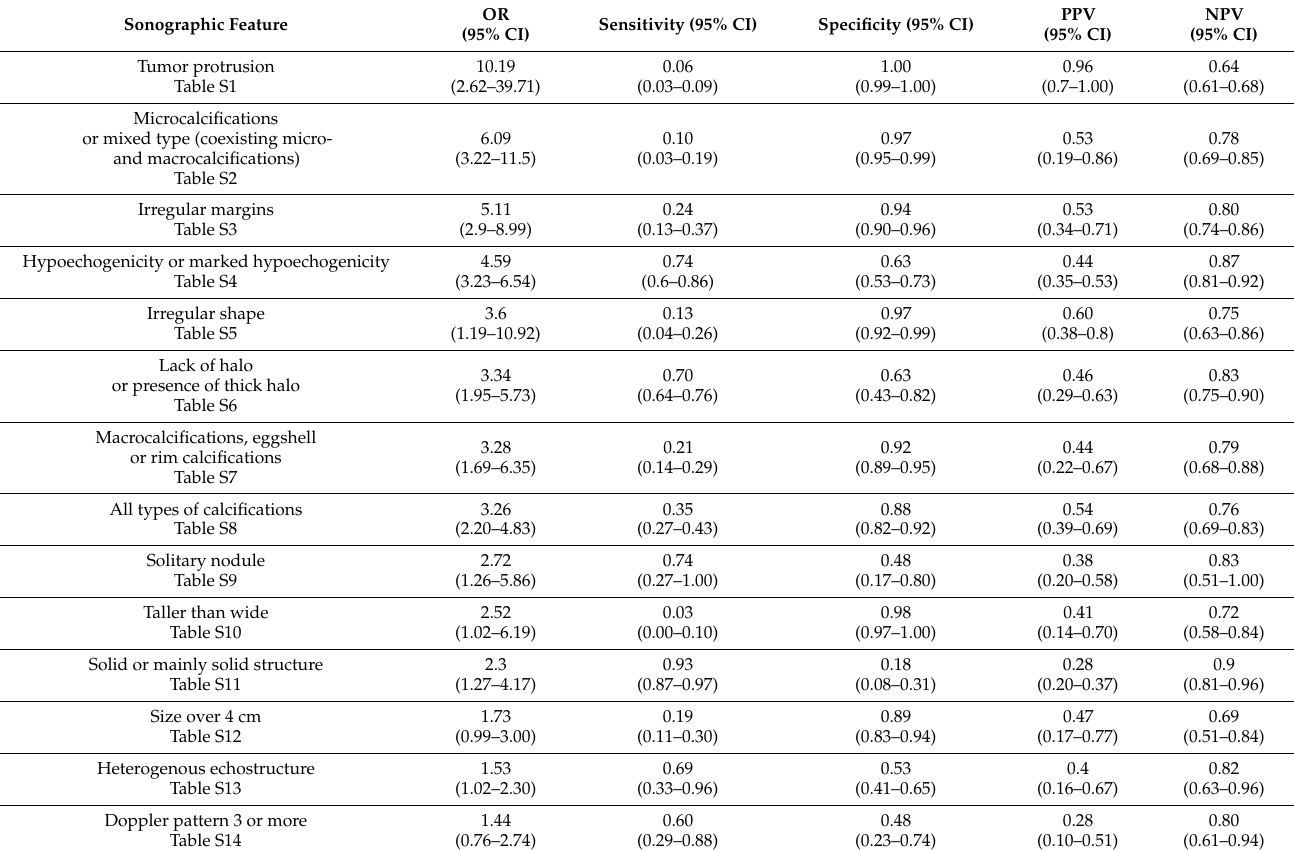
Table 2. Overall specificity, sensitivity, negative prognostic value (NPV), and positive predictive value (PPV) for sonographic features differentiating follicular thyroid cancer from follicular adenoma utility and their overall odds ratios (OR) with their 95% confidence intervals (95%